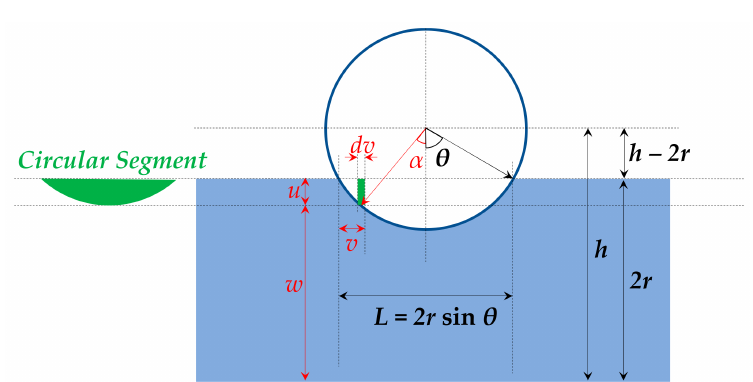
Figure A1. Schematics of a rod cross section and its overlap with a beneath and perpendicularly deposited filament. The parameters in black are fixed, while those in red are